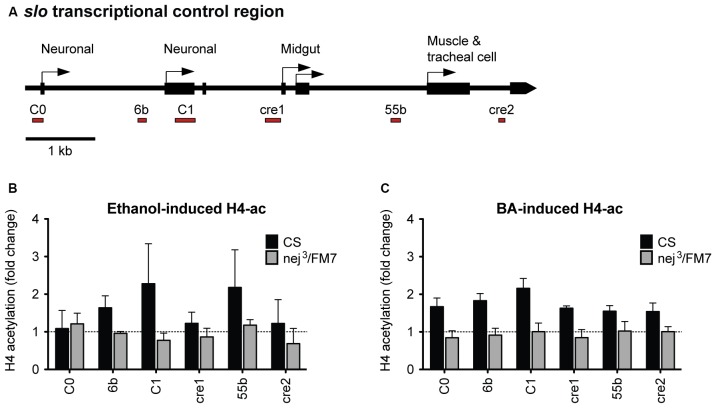
Alcohol-induced histone H4 acetylation change across the slo transcriptional control region are suppressed by a mutation in the nejire gene. (A) Levels of histone H4 acetylation were measured by ChIP-qPCR at six discrete highly conserved positions within the slo transcriptional control region. These regions are depicted below the slo transcriptional control region map, as red bars. (B) H4 acetylation changes induced by ethanol 6 h after treatment in CS and nej3/FM7 mutants. The mutation in nejire affects the histone acetylation pattern (two-way ANOVA, p = 0.04). (C) H4 acetylation changes induced by benzyl alcohol 6 h after treatment in CS and nej3/FM7 mutants. The mutation in nejire affects the histone acetylation pattern (two-way ANOVA, p < 0.0001).